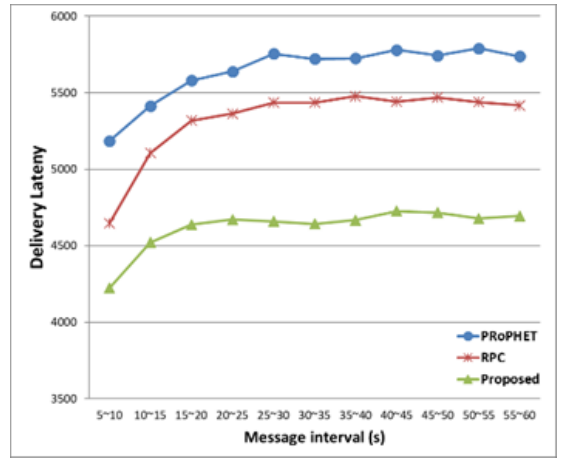
Figure 10. Delivery latency for different message intervals.